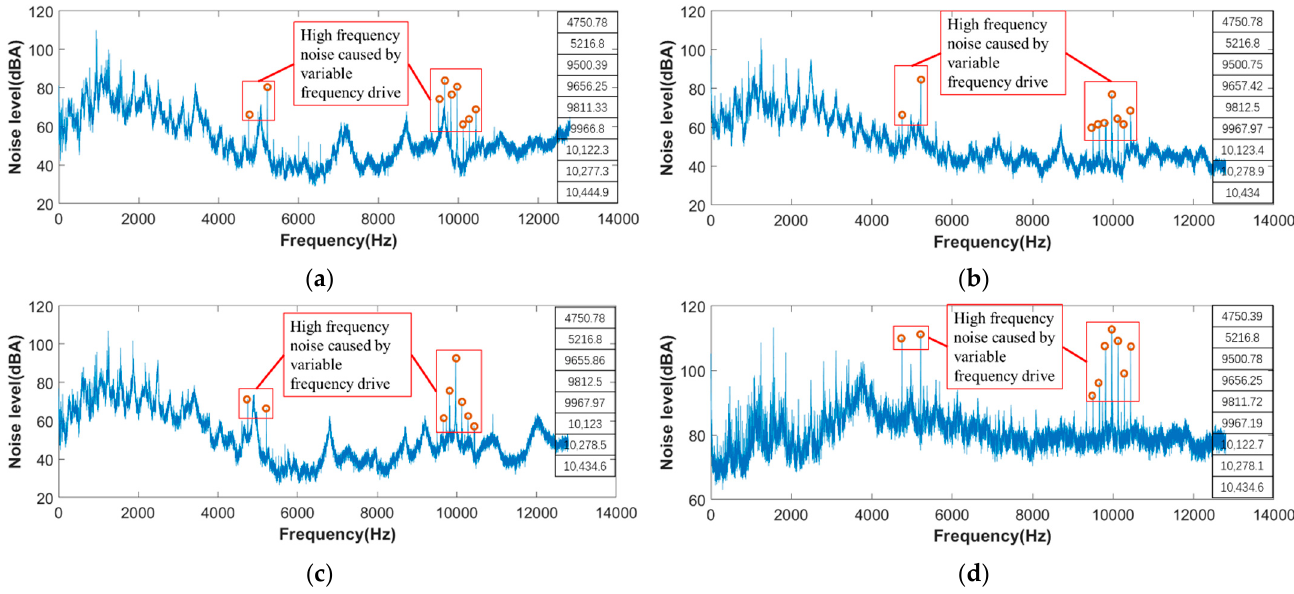
Figure 8. Spectrum of vibration acceleration: ( a ) testing point 1, ( b ) testing point 2, ( c ) testing point 3, ( d ) testing point 4 and ( e ) testing point 5.